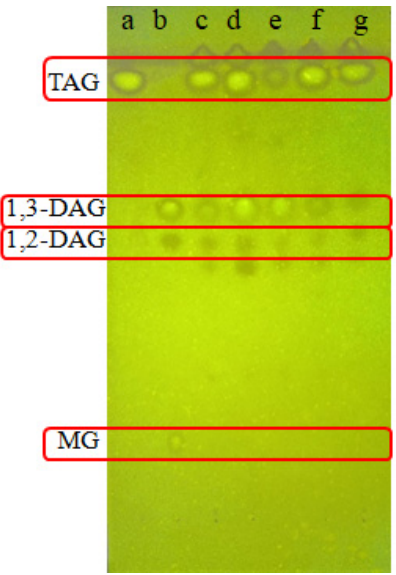
Figure 1. TLC bands of ( a ) TAG standard, ( b ) DAG standard (containing small amounts of MAG), ( c ) lipids from MLY23, ( d ) lipids from MLG23, ( e ) lipids from MLGP11, ( f ) lipids from MLP41, and ( g ) lipids from MLY31W.